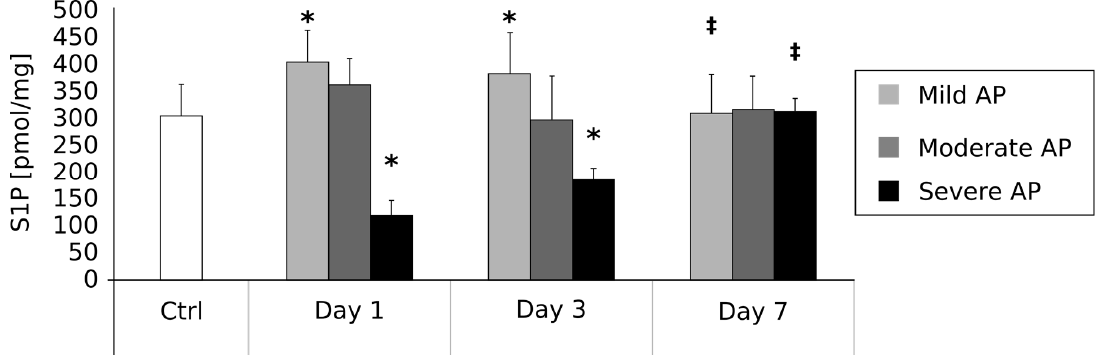
Figure 4. Alterations in sphingosine-1-phosphate (S1P) concentrations (pmol/mg) in the course of acute pancreatitis. * = difference vs. Control, p < 0.05; ‡ = difference vs. Day 1, p < 0.05.